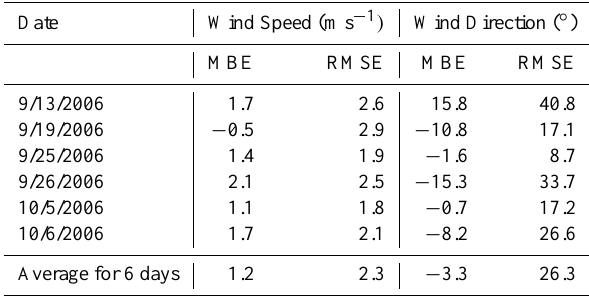
Table 3. Evaluation of the WRF-Chem model meteorology with wind profiler data at La Porte, Texas, for selected days. MBE de- notes mean bias error and RMSE stands for root mean square